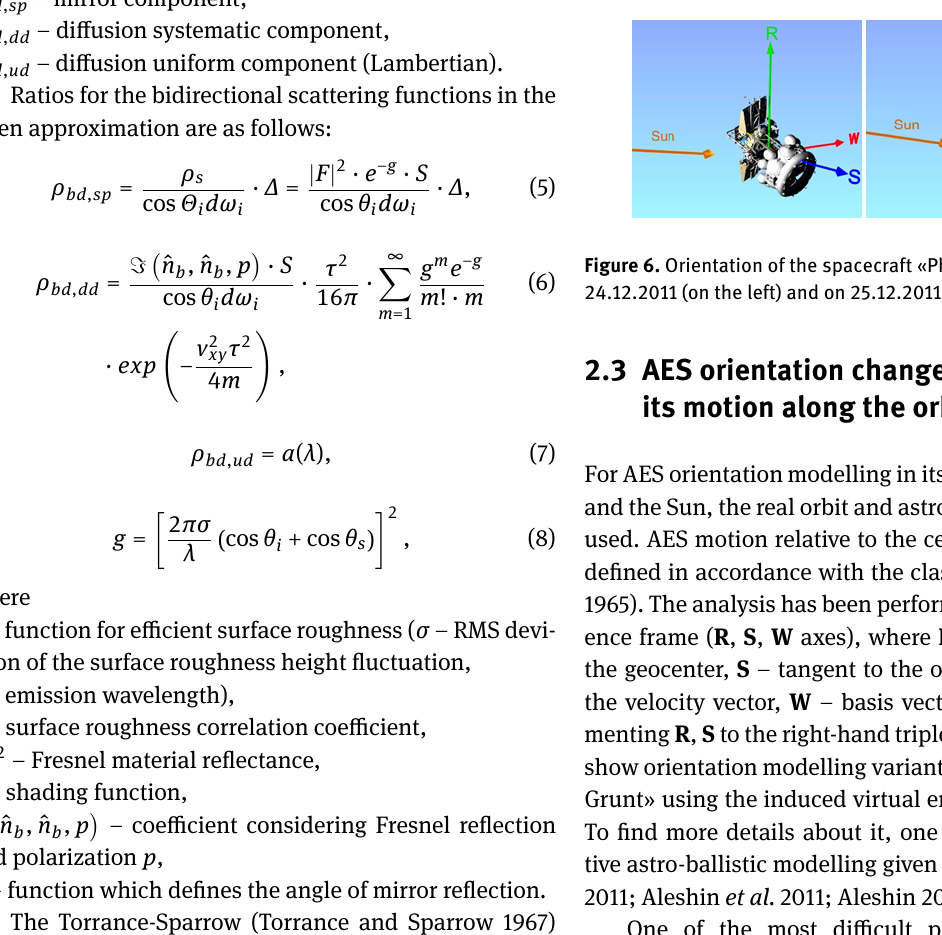
Figure 5. Orientation of the spacecraft «Phobos-Grunt» on 29.11.2011 (on the left) and on 23.12.2011 (on the right)